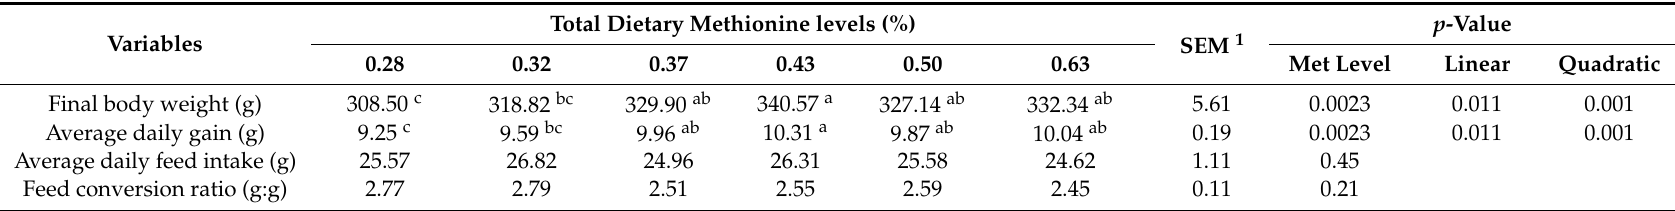
Table 6. E ff ects of total dietary methionine level on growth performance of female Guangxi yellow-feathered chickens aged 1 to 30 days.